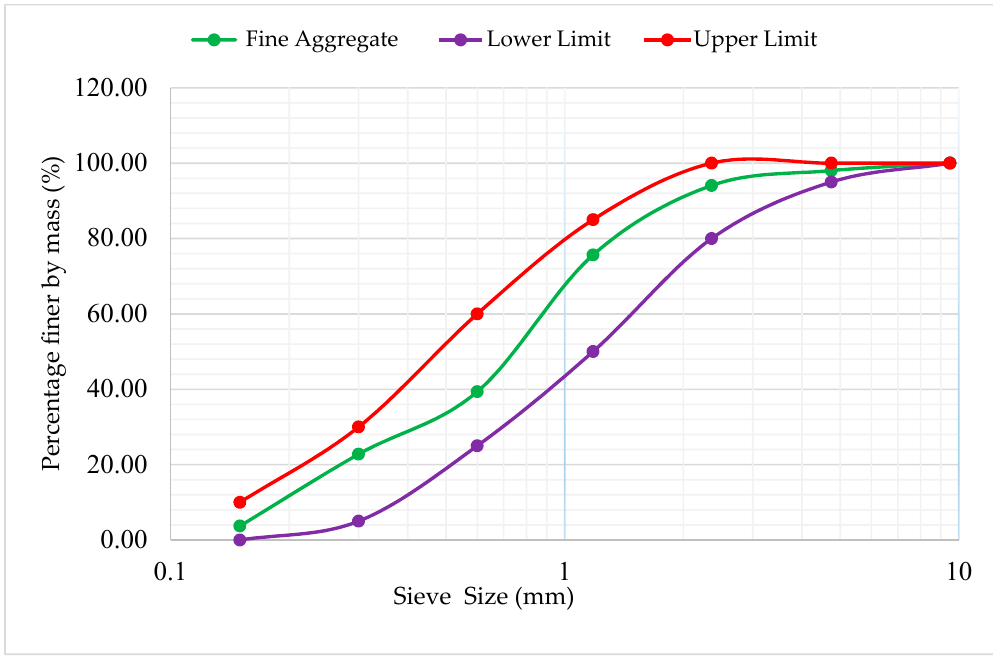
Figure 1. Particle size distribution of fine aggregate.